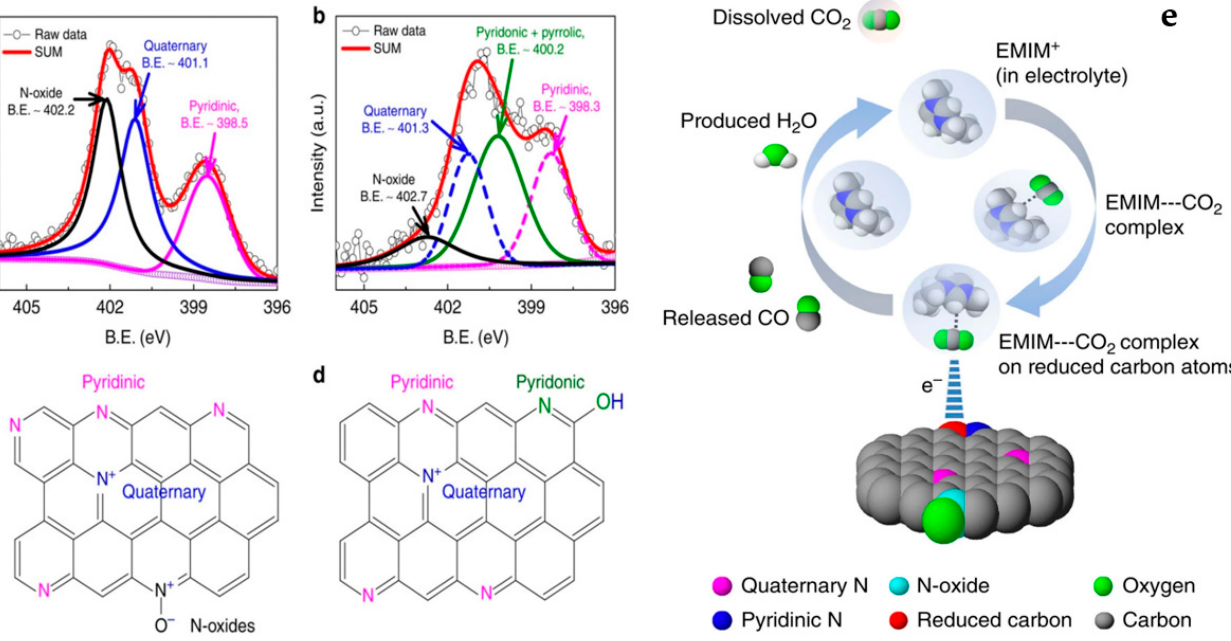
Figure 7. ( a – d ) Evolution of nitrogen atomic nature in CNFs by XPS. ( a ) Deconvoluted N1s spectra for CNFs before and ( b ) after electrochemical experiments. In used catalysts, CNFs N1s spectra, N-oxide type of nitrogen content reduced radically and new peak (green solid line) at 400.2 eV (pyridonic N) appears. ( c , d ) The corresponding atomic structure on the basis of XPS analysis. ( e ): CO 2 reduction mechanism schematic diagram. The CO 2 reduction reaction takes place in three steps: (1) an intermediate (EMIM–CO 2 complex) formation, (2) adsorption of EMIM–CO 2 complex on the reduced carbon atoms, and (3) CO formation. (Reprinted with permission from Ref. [36]. Copyright 2013 SpringerNature).